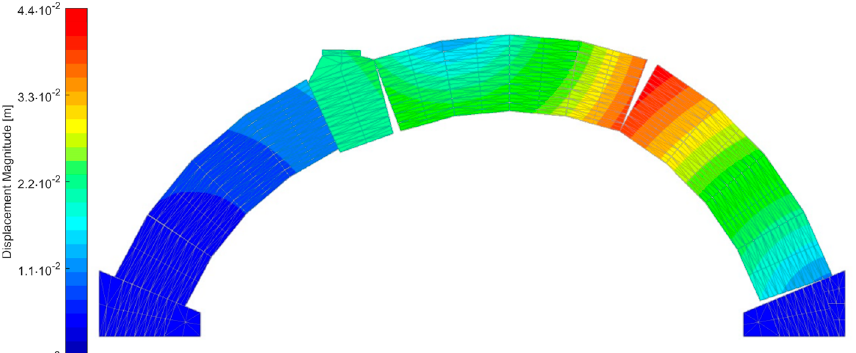
Figure 19. Failure mode of Pulatsu’s geometry for best set of material parameters using objective